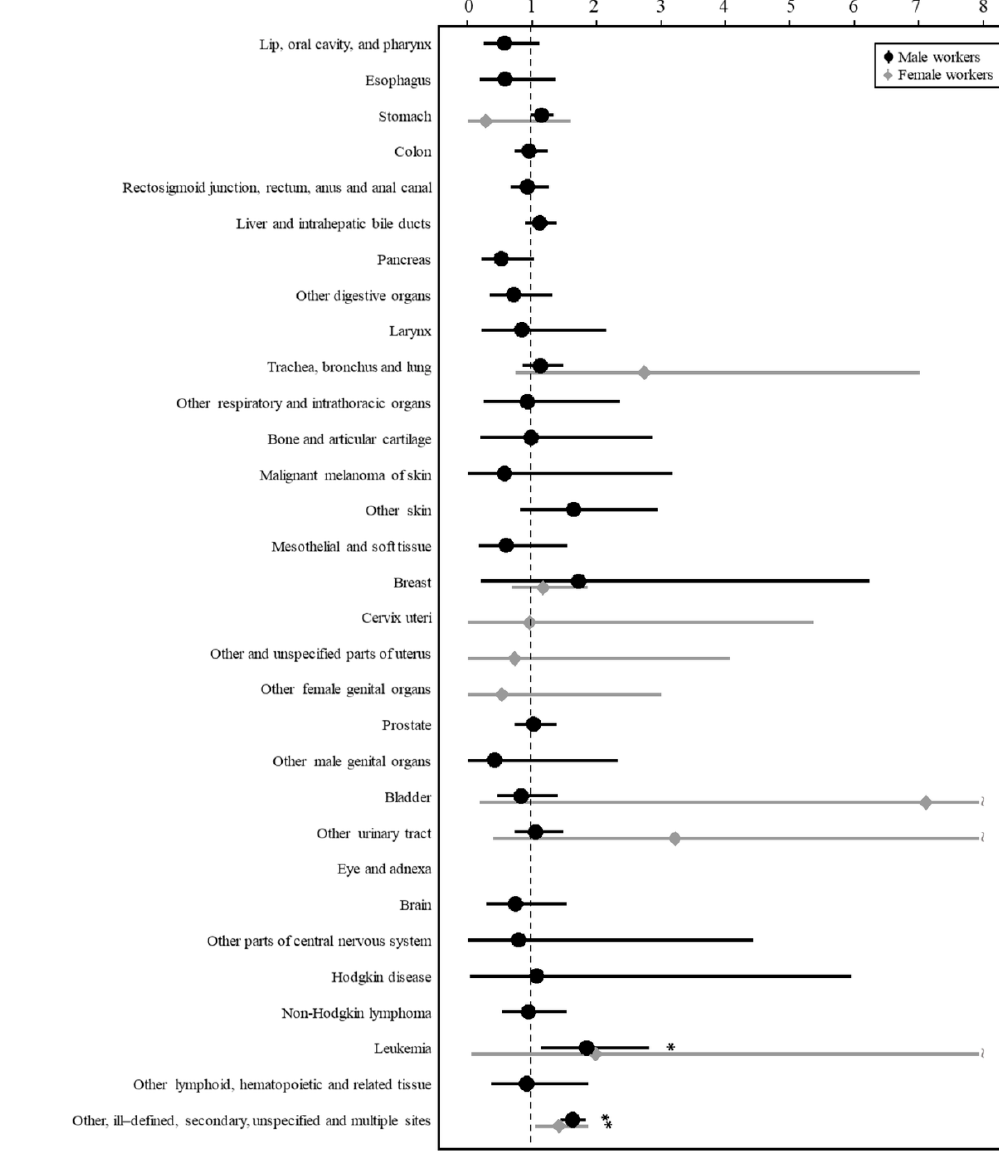
Figure 1. Age-standardized incidence rate (95% confidence interval) of cancers referenced with the government employee.